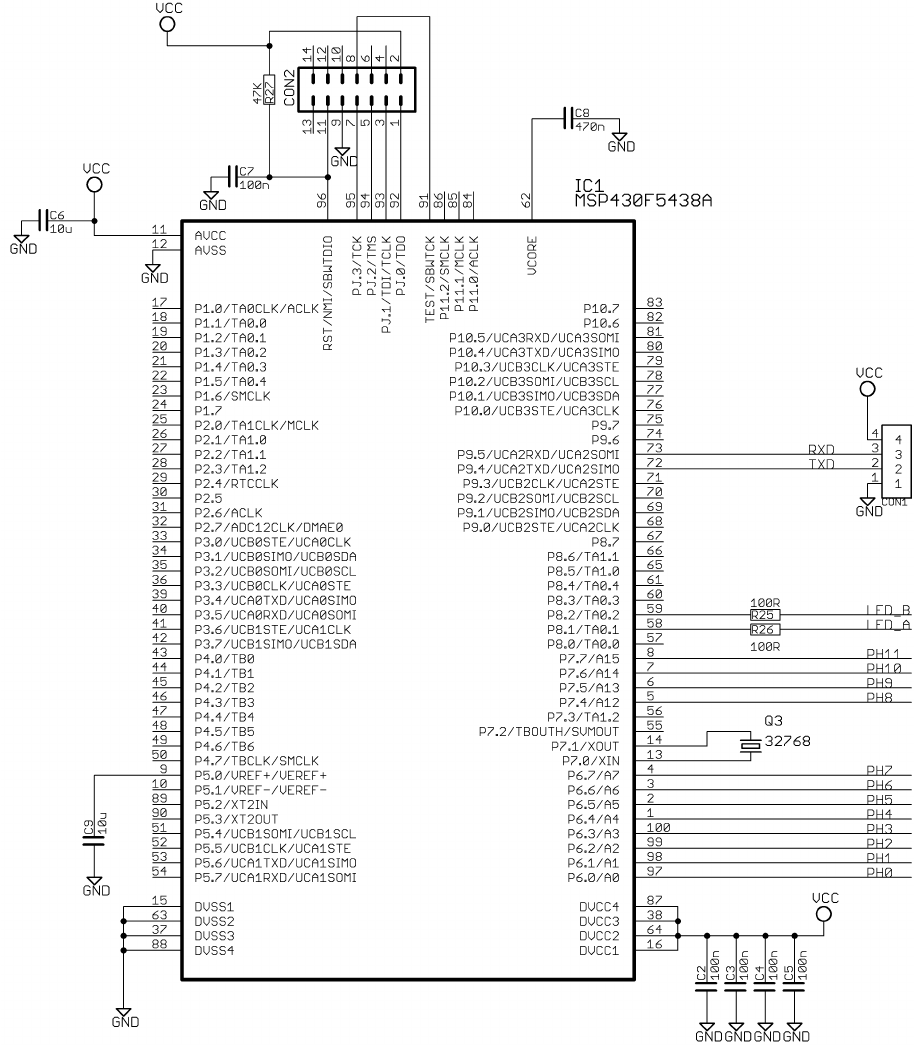
Figure A1. The bee counter stage processor. It is based on Texas Instruments' MSP430F5438A microcontroller. The LED_A output activates the LEDs located on the outside of the counter and the LED_B activates the LEDs located on the inner side of the counter. PH 0 – PH11 signals are the outputs of phototransistors and through them, in combination with active LEDs, the processor recognizes there is a bee in the tunnel and whether it enters or exits.